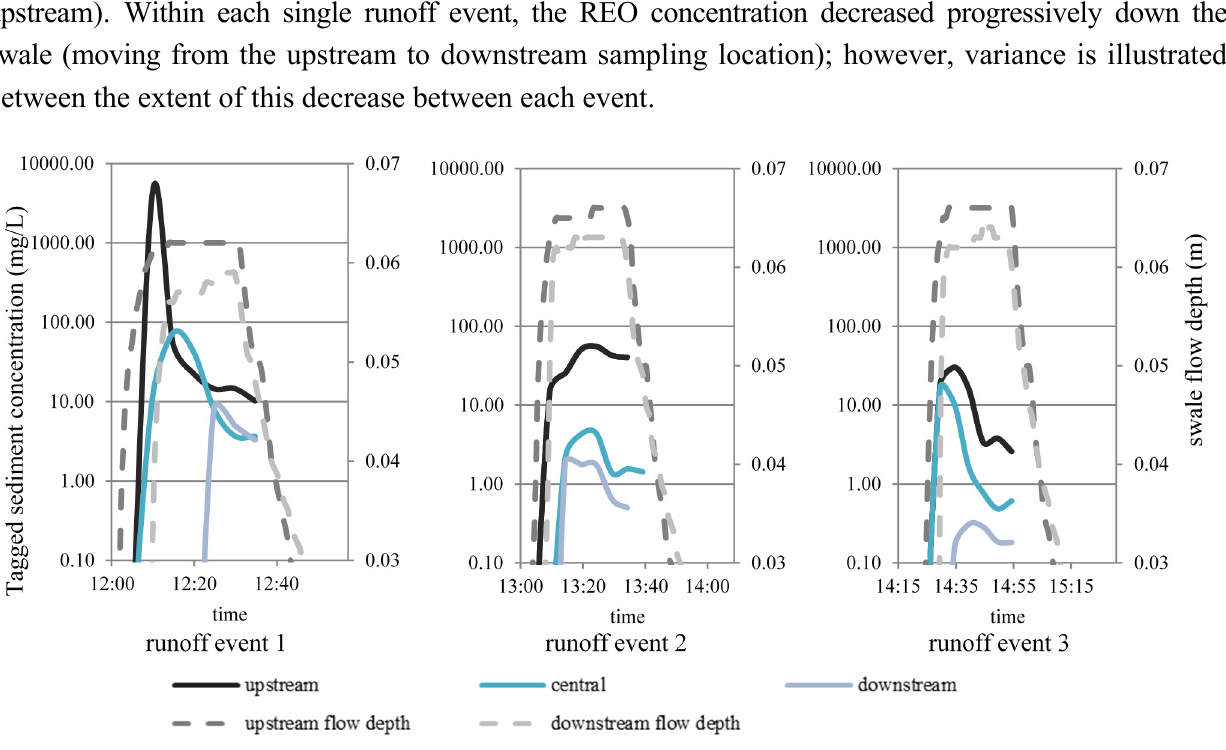
Figure 3. REO tagged sediment concentrations for artificial runoff events at the three surface runoff monitoring locations within the swale (upstream, central, and downstream locations)—Experiment 1